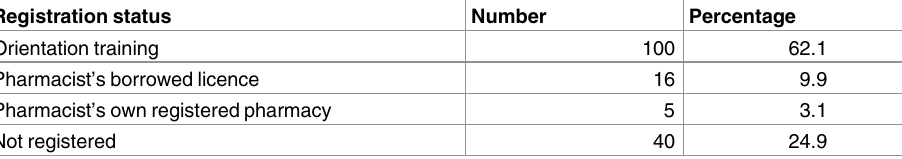
Table 2. Registration status of community pharmacies(n =